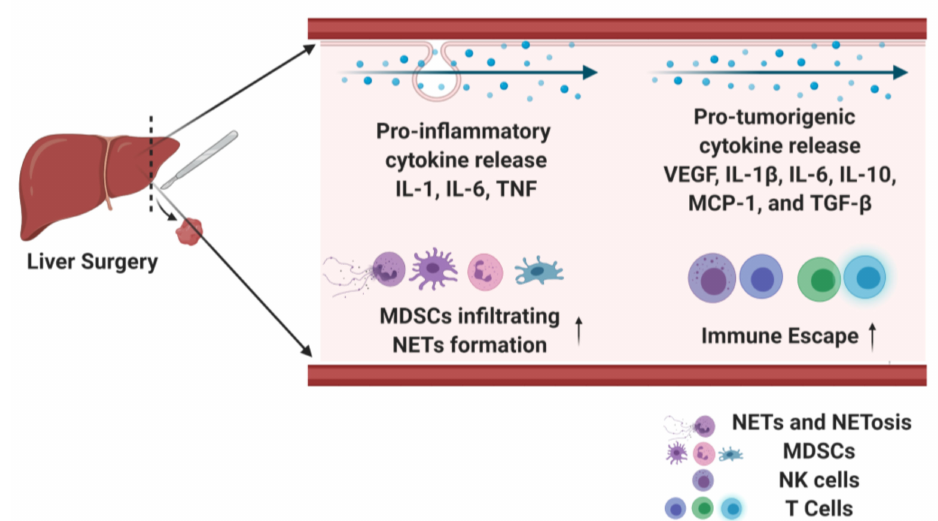
Figure 2. Surgical stress leads to pro-inflammatory and pro-tumorigenic cytokine release, which increase tumor